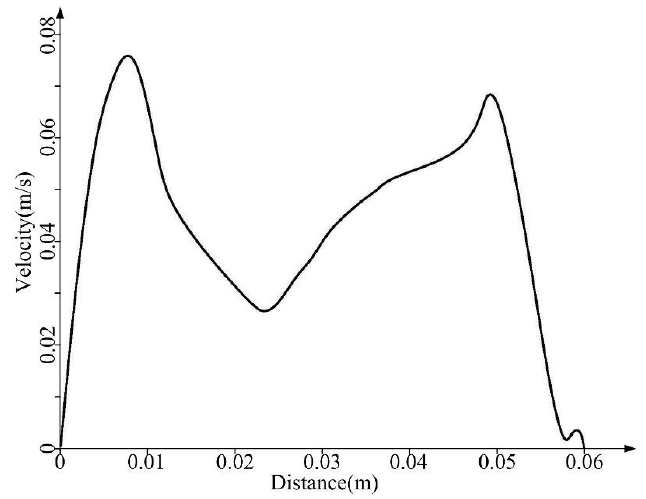
Figure 10. Tangential velocity profile in constrained flow passage.